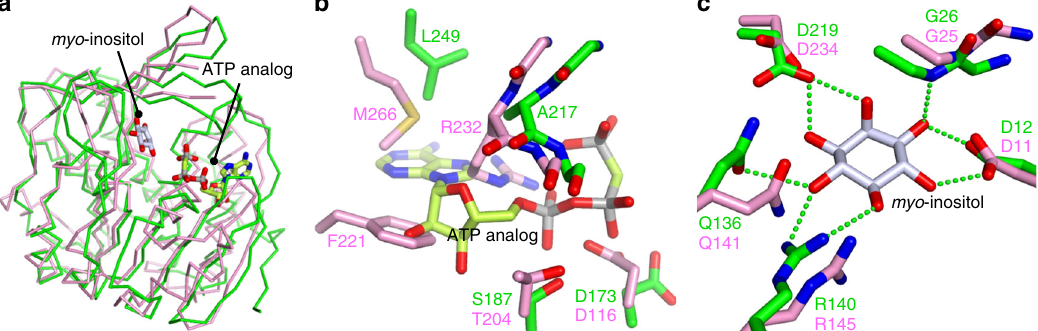
Fig. 1 Structural comparison between TM0415 and MI3K_TK. The structures of the unliganded TM0415 (PDB ID 1VK4) and the substrate complex of MI3K_TK (4XF7) are shown in pink and green, respectively. a Superposition of the C α traces of the overall structures. b , c Comparison of the phosphate- donor- or acceptor-binding site. Green dotted lines represent the interactions between myo -inositol and the residues in MI3K_TK. The ligands and residues in the ligand-binding site are shown as